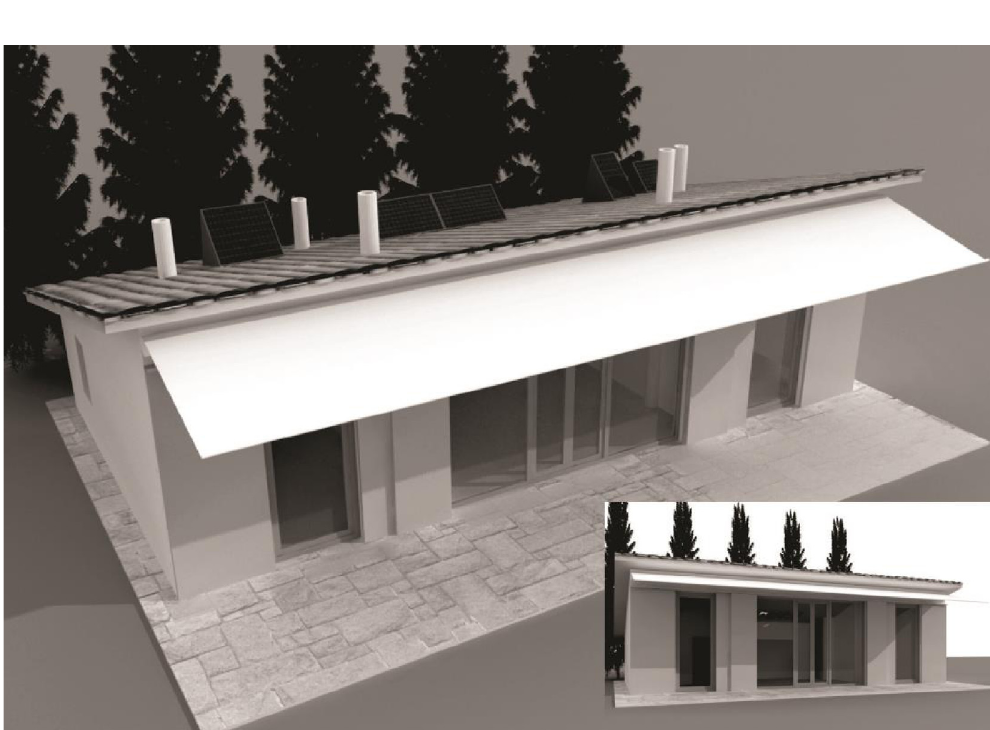
Fig. 8. Perspectives of House